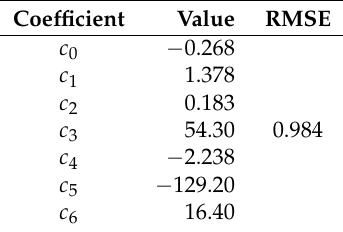
Table 3. Split-Window Algorithm coefficients for Jiménez-Muñoz et al.’s (2014) algorithm as